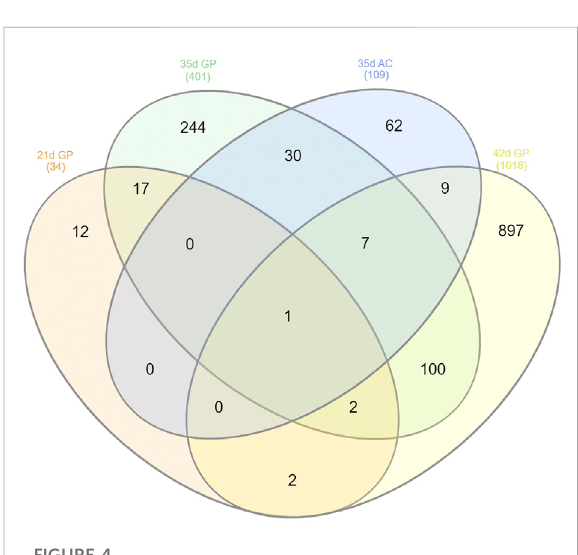
FIGURE 4 Venn diagram of DE genes in the femur GP of 21 and 35 days of age, tibia GP of 42 days of age and AC of 35 days of